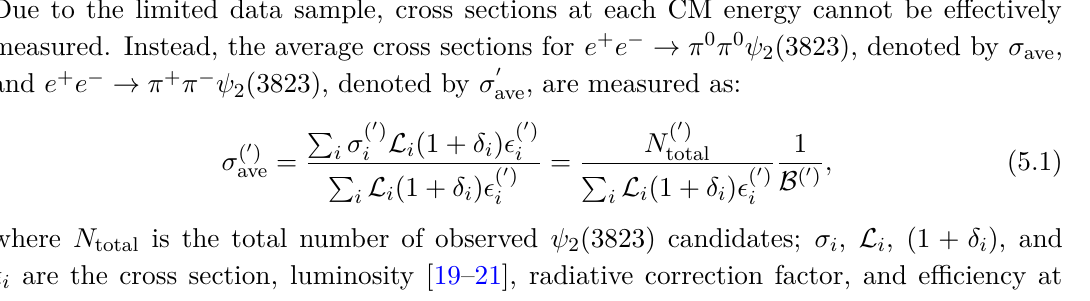
Figure 1 . The fit to the M ( γγJ/ψ ) distribution for the data from dots with error bars are the data. The red solid curve is the total fit. The blue dashed curve is the background in the fit and the green filled histogram is the normalized background from the inclusive MC